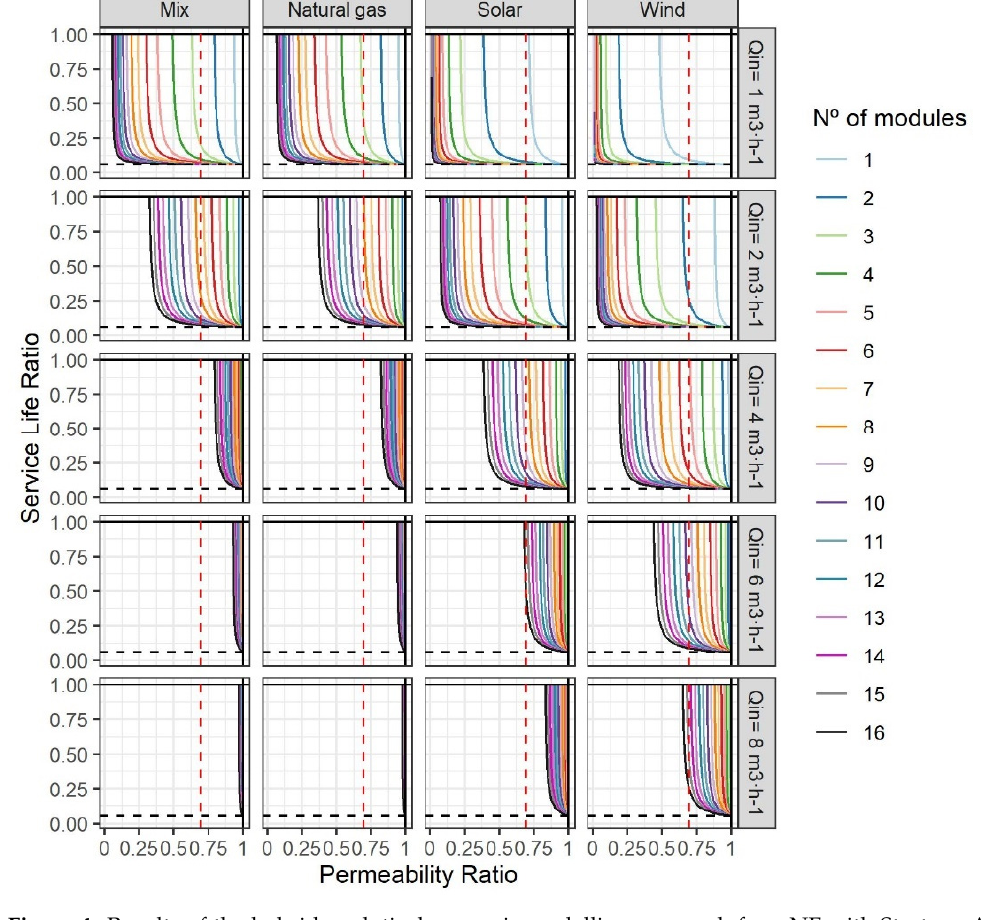
Figure 4. Results of the hybrid analytical–numeric modelling approach for r-NF with Strategy A. Reference scenario for NF-270: SL = 10 years and WR = 0.5. The dashed red line illustrates LR from the case study (0.69) and the dashed black lines the ratio of replacement impact (0.0579).